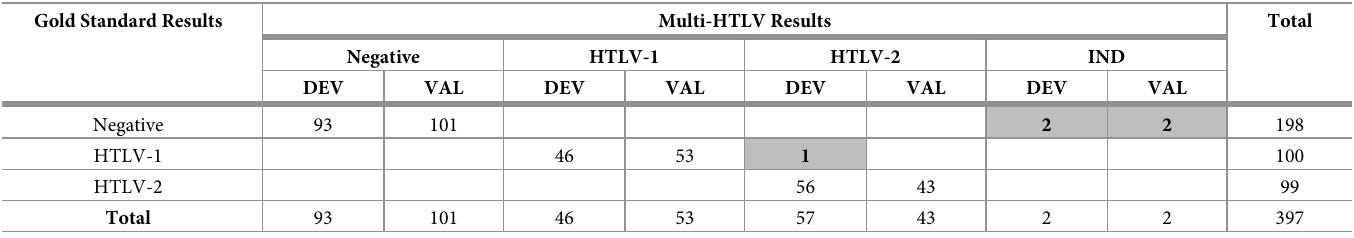
Results are expressed by the number of samples, and calculated after applying the algorithm. All samples tested with Multi-HTLV were compared with gold standard results.